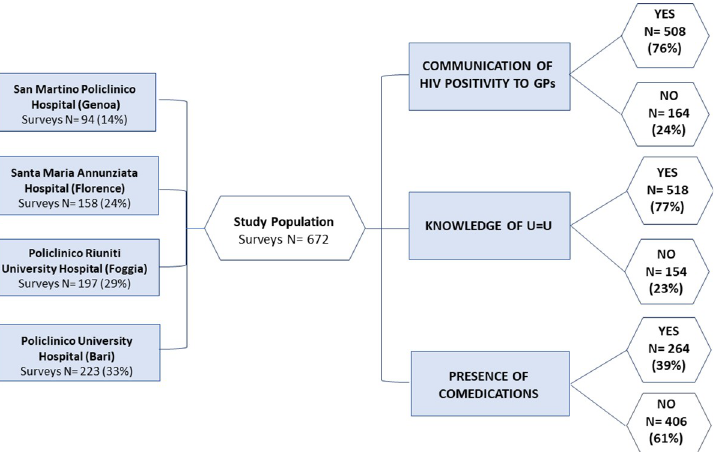
Fig 1. Study design. The number of surveys collected in the four participating Centers is reported, along with three main topics investigated (communication of HIV positivity to GP, knowledge of U = U, presence of comedications) and frequency of answers collected for each